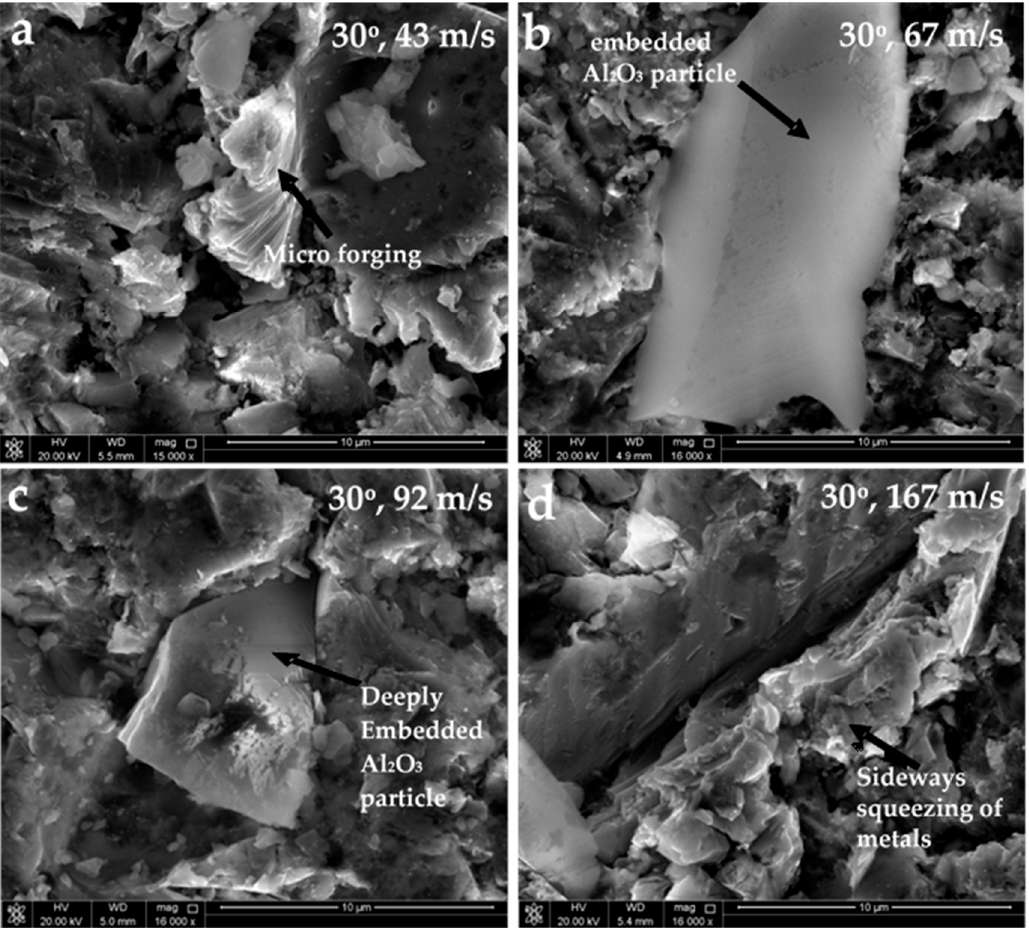
Figure 6. SEM micrograph of steel specimen after erosion at 30 ◦ impact angle and different particle speeds of ( a ) 43 m · s − 1 , ( b ) 67 m · s − 1 , ( c ) 92 m · s − 1 , ( d ) 167 m · s − 1 . At lower impact angles (e.g., 30 ◦ , 45 ◦ ) and lower particle speed (e.g., 43 m · s − 1 ), the target